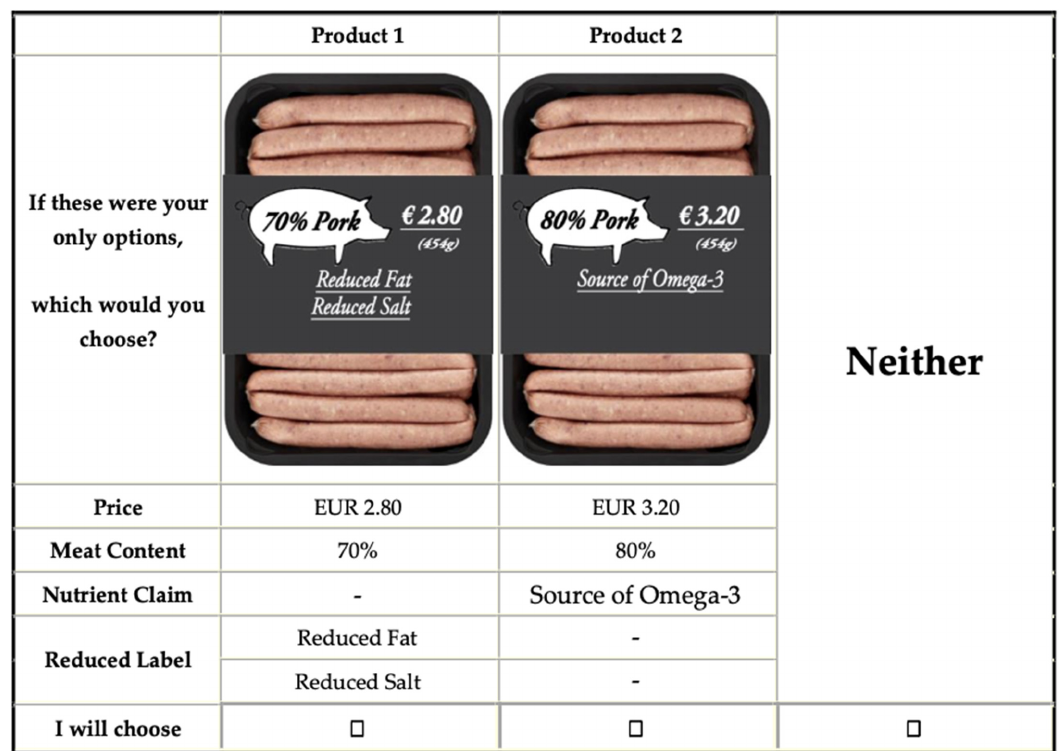
Figure A12. Choice set 12 in the questionnaire